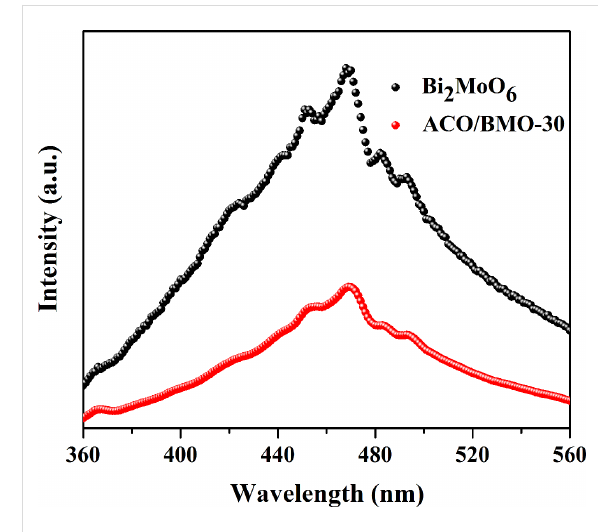
Figure 5: PL spectra of bare Bi 2 MoO 6 and